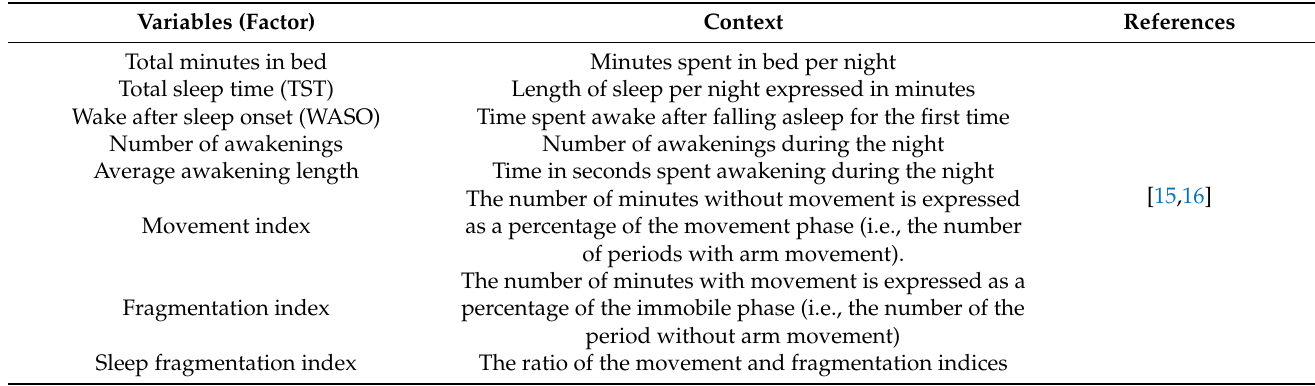
Table 1. Context of independent